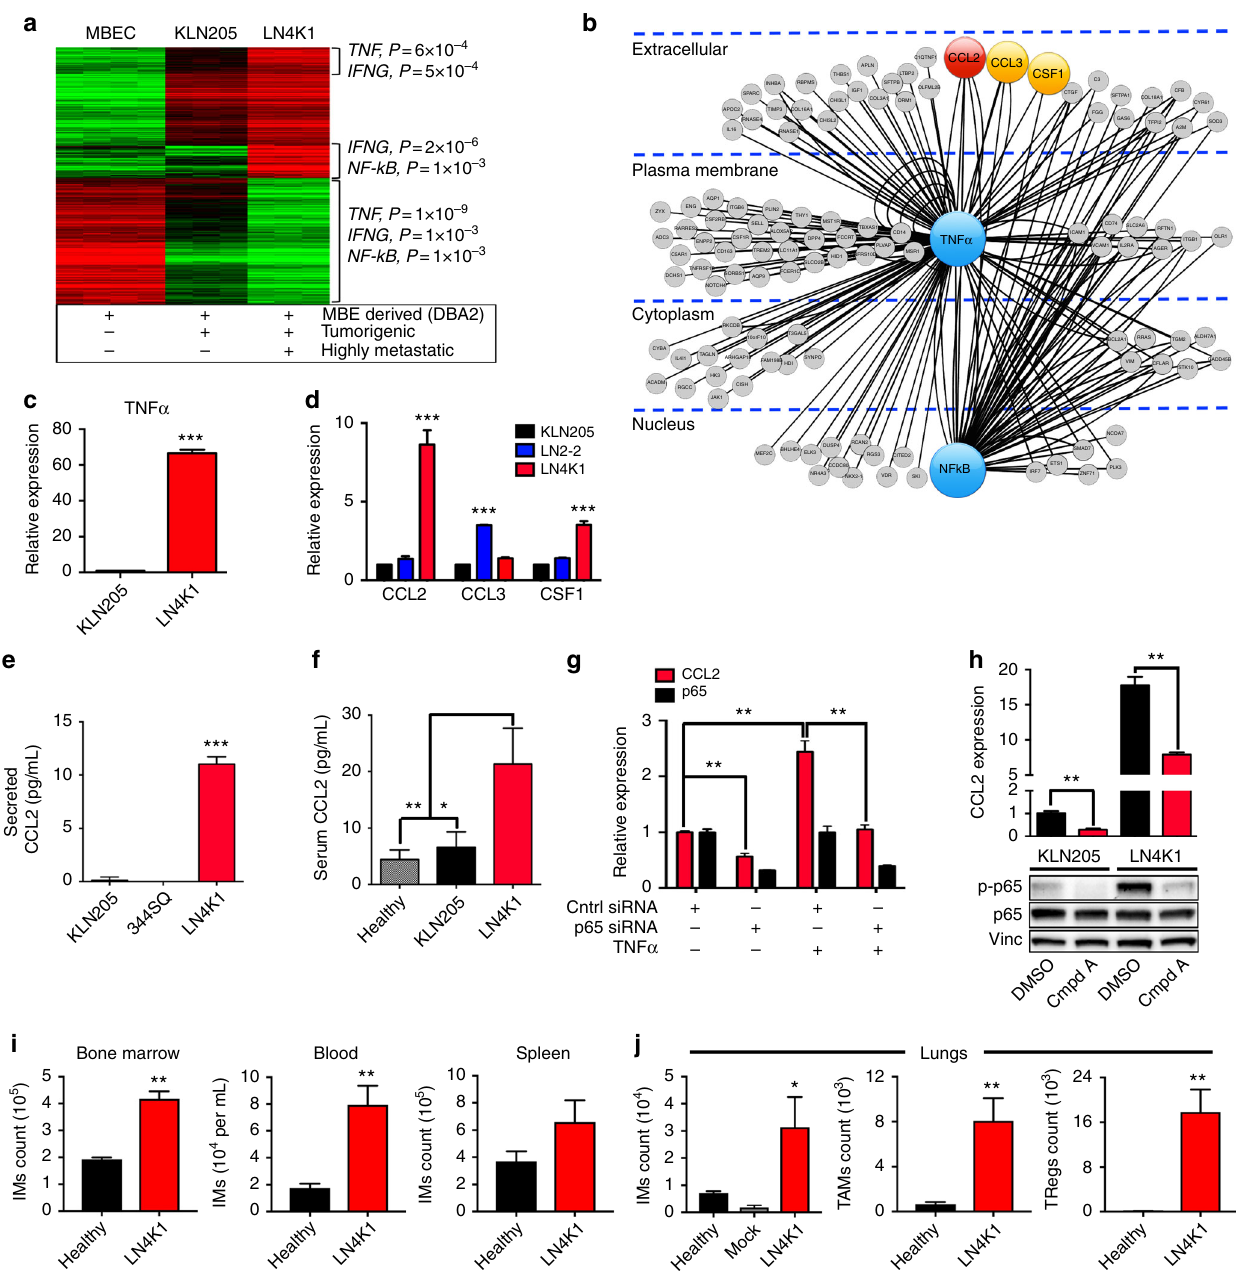
Fig. 4 TNF α activation of NF κ B promotes CCL2-mediated IM recruitment. a Microarray expression data (left) comparing murine bronchial epithelial cells (MBECs), parental KLN205 and the LN4K1 sub-clone. Top upstream pathways (right) from Ingenuity Pathway Analysis (IPA) are shown for the differentially regulated genes shown in brackets. b An upstream network visualization from IPA of all over-expressed genes (all nodes) in the upper portion of the heat map shown in Fig. 1c with signi fi cant log-rank (survival analysis) p -value ( < 0.05). TNF α and NF κ B (blue nodes) were amongst the top upstream regulators known to have direct roles (black lines) in promoting CCL2, CCL3 and CSF1 chemokines (the degree of redness corresponds with increasing statistical signi fi cance). c Relative expression of TNF α . d CCL2, CCL3 and CSF1 by qPCR. Data are averages ± s.e.m. P -values were obtained with Student ’ s t-test in comparison with KLN205. e Relative levels of CCL2 as measured by ELISA from secreted media of cells growing in vitro or, f , from plasma of tumor-bearing mice. Data are averages ± s.e.m. g Relative mRNA expression of CCL2 and p65 in LN4K1 cells following treatment with control or p65 siRNA with or without exogenous TNF α (100 ng/mL). h Relative expression of CCL2 mRNA (top) and phospho-p65 and p65 protein (bottom) following treatment with DMSO or an IKK β inhibitor (Compound A, 5 μ M) for 5 h. i Relative IM counts in the bone marrow, blood, spleen from healthy DBA2 mice versus those with LN4K1 tumors. j Relative IM, TAM and TReg counts from the lungs of healthy versus LN4K1-bearing mice. IMs were also assessed in age-matched DBA2 mice following HBSS ‘ Mock ’ injection. P -values obtained with one-sided Student ’ s t-test, n = 5 mice/group for f , i , and j . * P < 0.05, ** P ≤ 0.01, *** P ≤